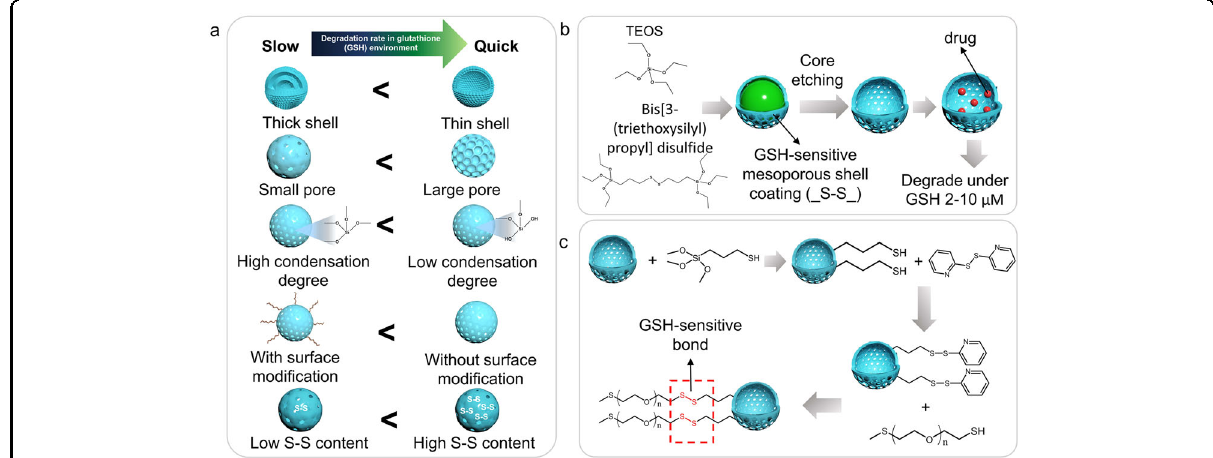
Fig. 11 Overview of the design of mesoporous nanoparticles used in the glutathione (GSH) environment. a Comparison of the degradation rate in mesoporous silica nanoparticles; ( b ) modi fi cation based on core – shell nanoparticles; and ( c ) conjugation with GSH-sensitive